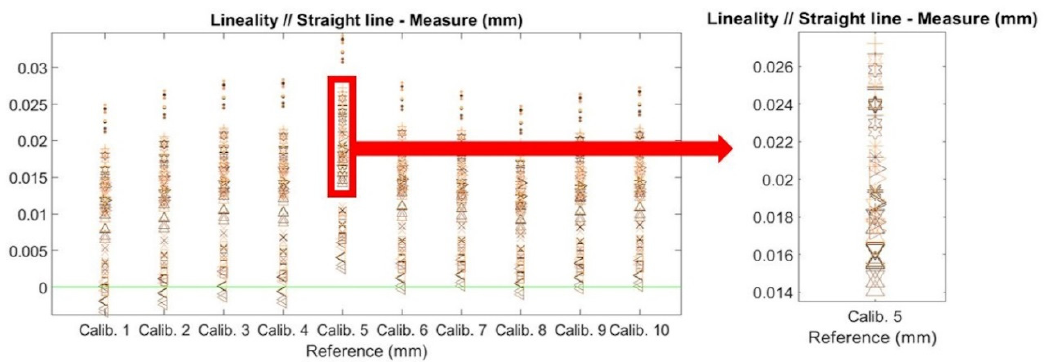
Figure 11. Measurement combination distribution for ten different camera calibrations, with each calibration divided into different measurements.